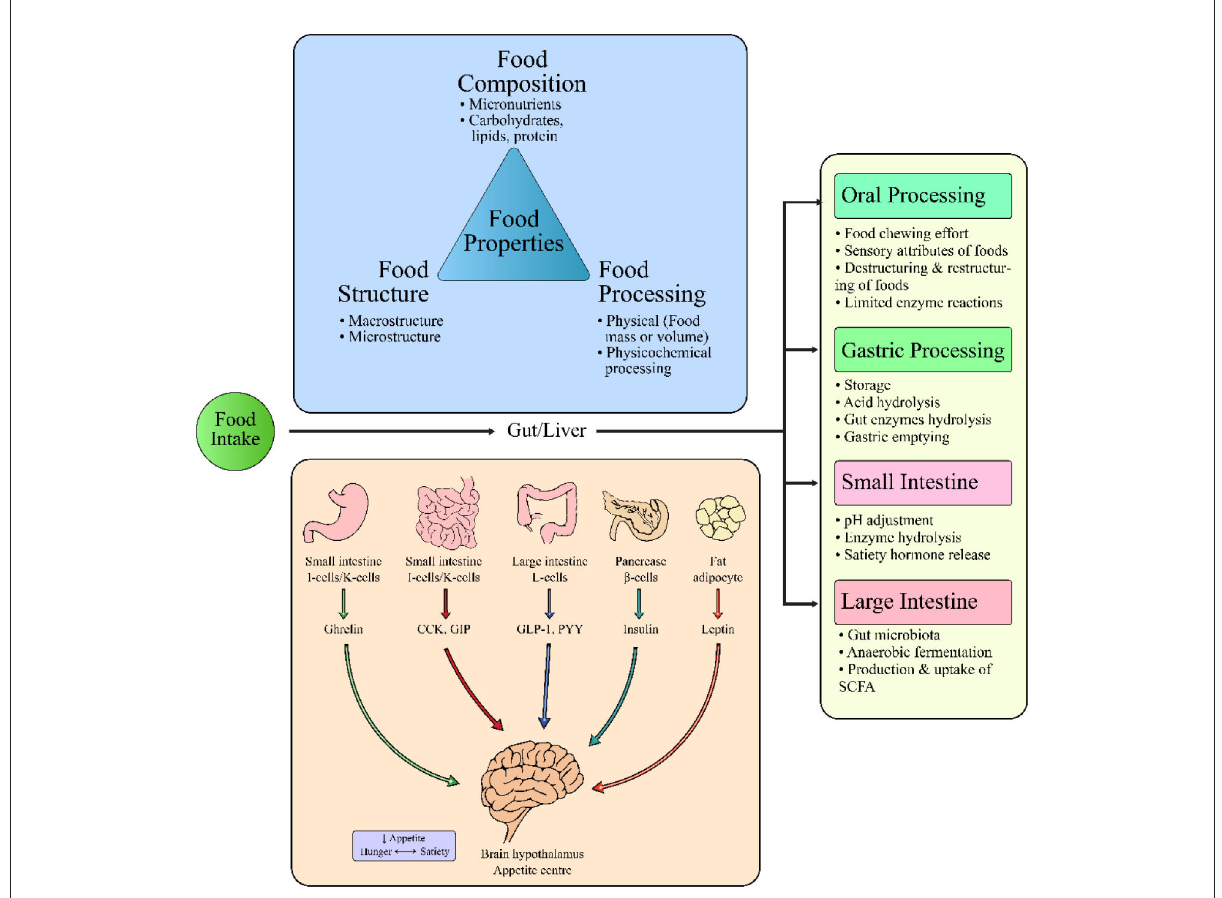
FIGURE2 Interrelation of food properties and internal factors controlling food intake, satiation or